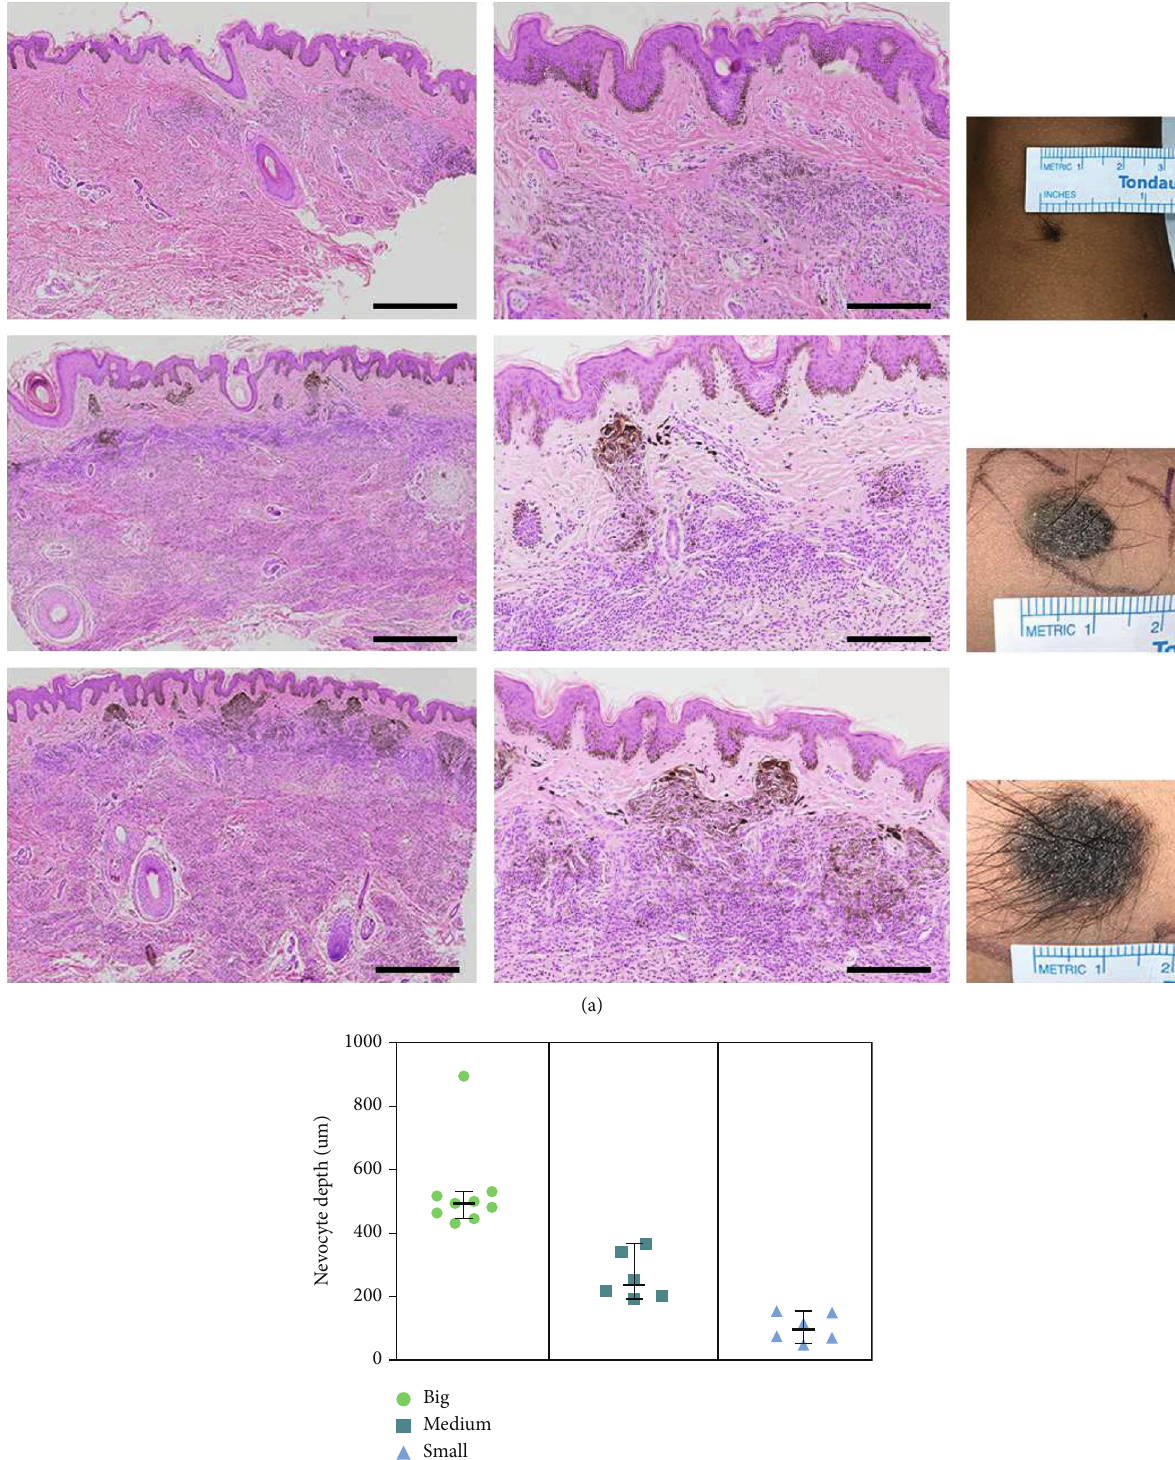
Figure 2: The in fi ltration depth of nevocytes varied with the size of satellite nevi. (a) H&E staining and clinical images of satellite nevi from small to big; the bigger the satellite nevus was, the deeper in the dermis where the nevocytes were deposited, with more melanin at the DEJ ( scale bar = 500 μ m in the fi rst column and 200 μ m in the second column; DEJ: dermal-epidermal junction). (b) The nevocyte in fi ltration depth of big, medium, and small satellite